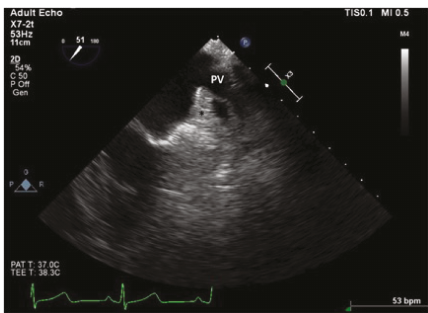
Figure 5: TEE at 50 degrees angle midesophageal view showing the coumadin ridge and pulmonary vein (PV). Note that there is no left atrial appendage in the area marked with ( ∗